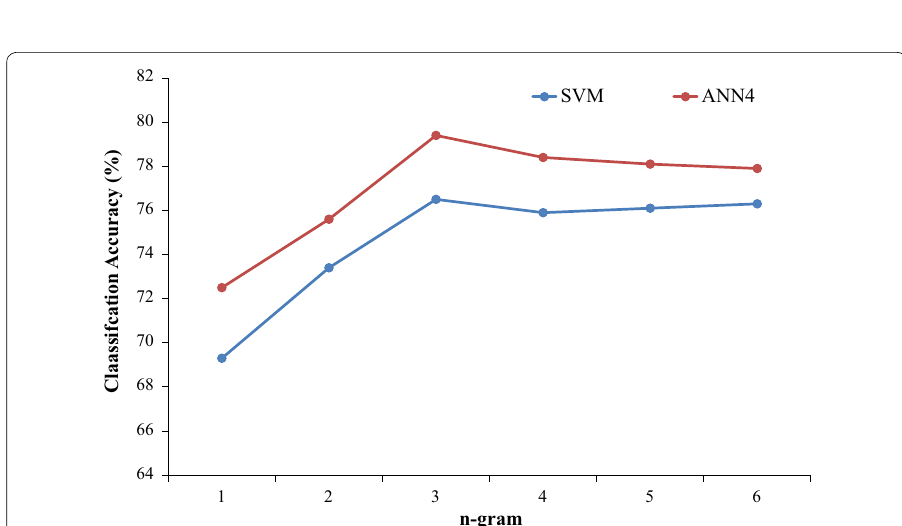
Fig. 4 Performance of SVM and ANN models for different n-gram